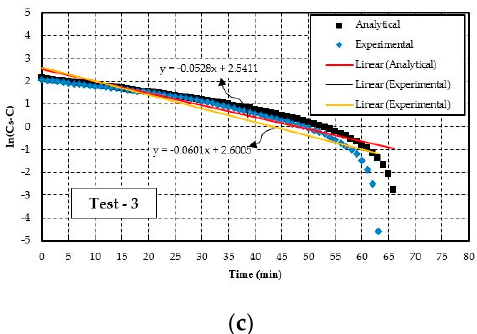
Figure 6. Determination of oxygen transfer coefficient for three test conditions defined in Table 2: ( a ) Test-1; ( b ) Test-2; ( c ) Test-3.